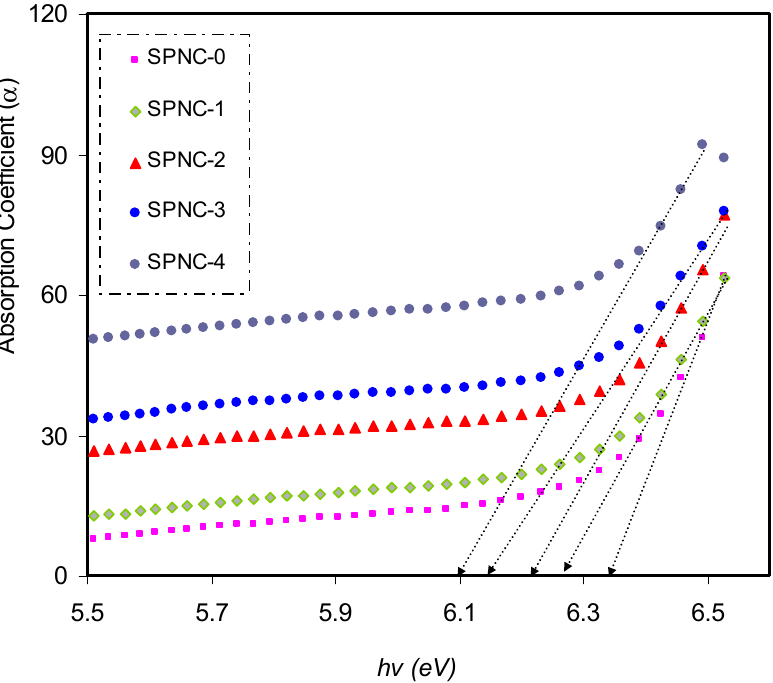
Figure 5. Shift in absorption coefficient ( α ) for CeO 2 -doped samples relative to the pure sample. Table 3. Values of absorption edge for the whole prepared samples.